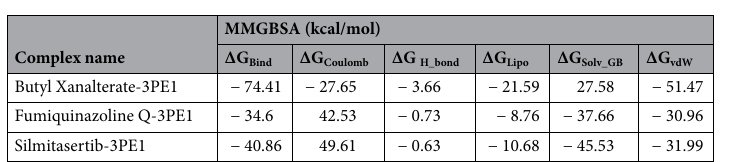
Figure 10. Histogram shows protein residues that interact with the ligand over the course of the trajectory.